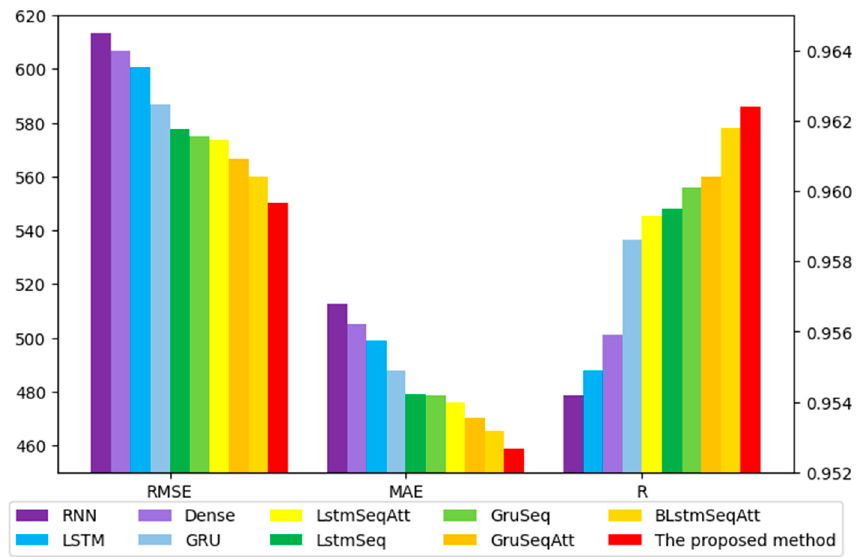
Figure 9. RMSE, MAE, and R of different models.